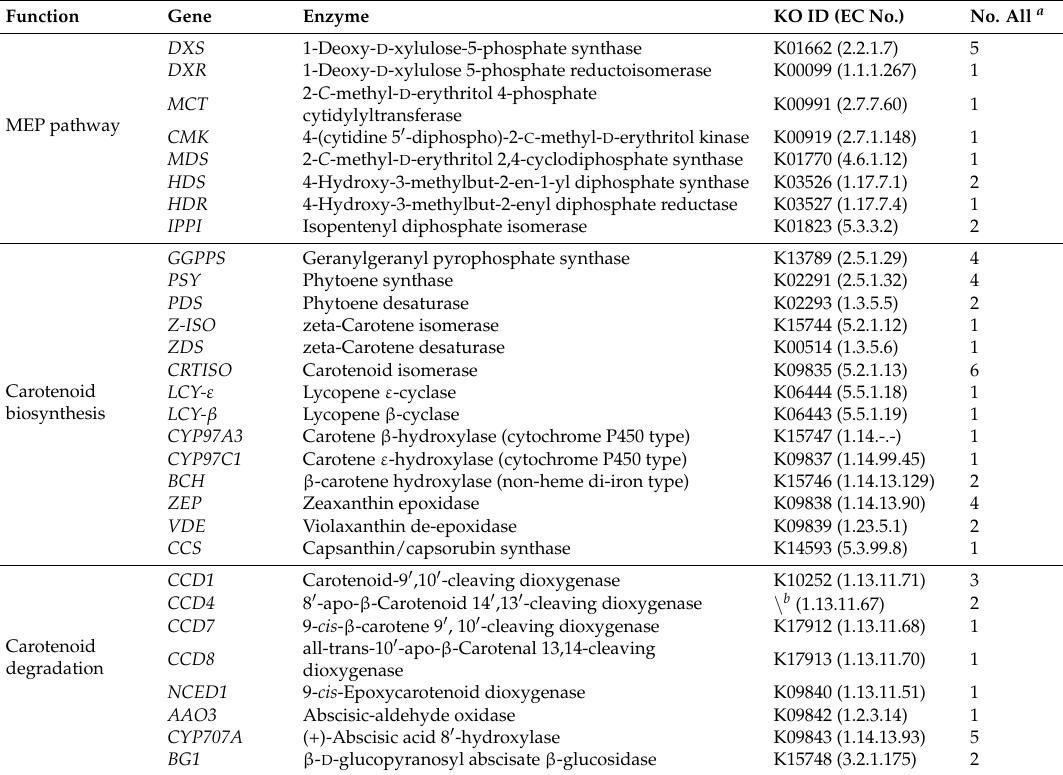
Table 2. Unigenes related to carotenoids metabolic pathway in tepals of Chinese narcissus.